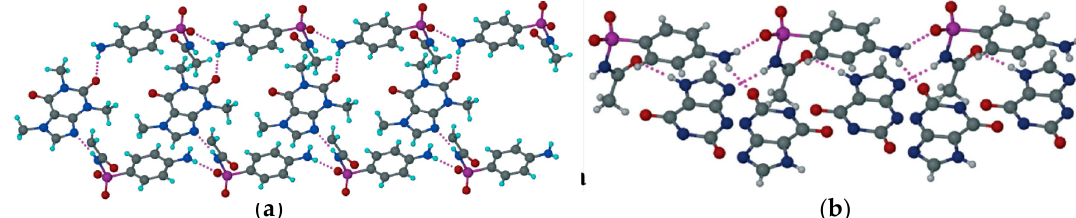
Figure 14. N–H···O and N–H···N hydrogen bond connecting sulfacetamide and coformer ( a ) caffeine and ( b ) theophylline in the respective cocrystals. Adapted with permission from CrystEngComm , 2014,